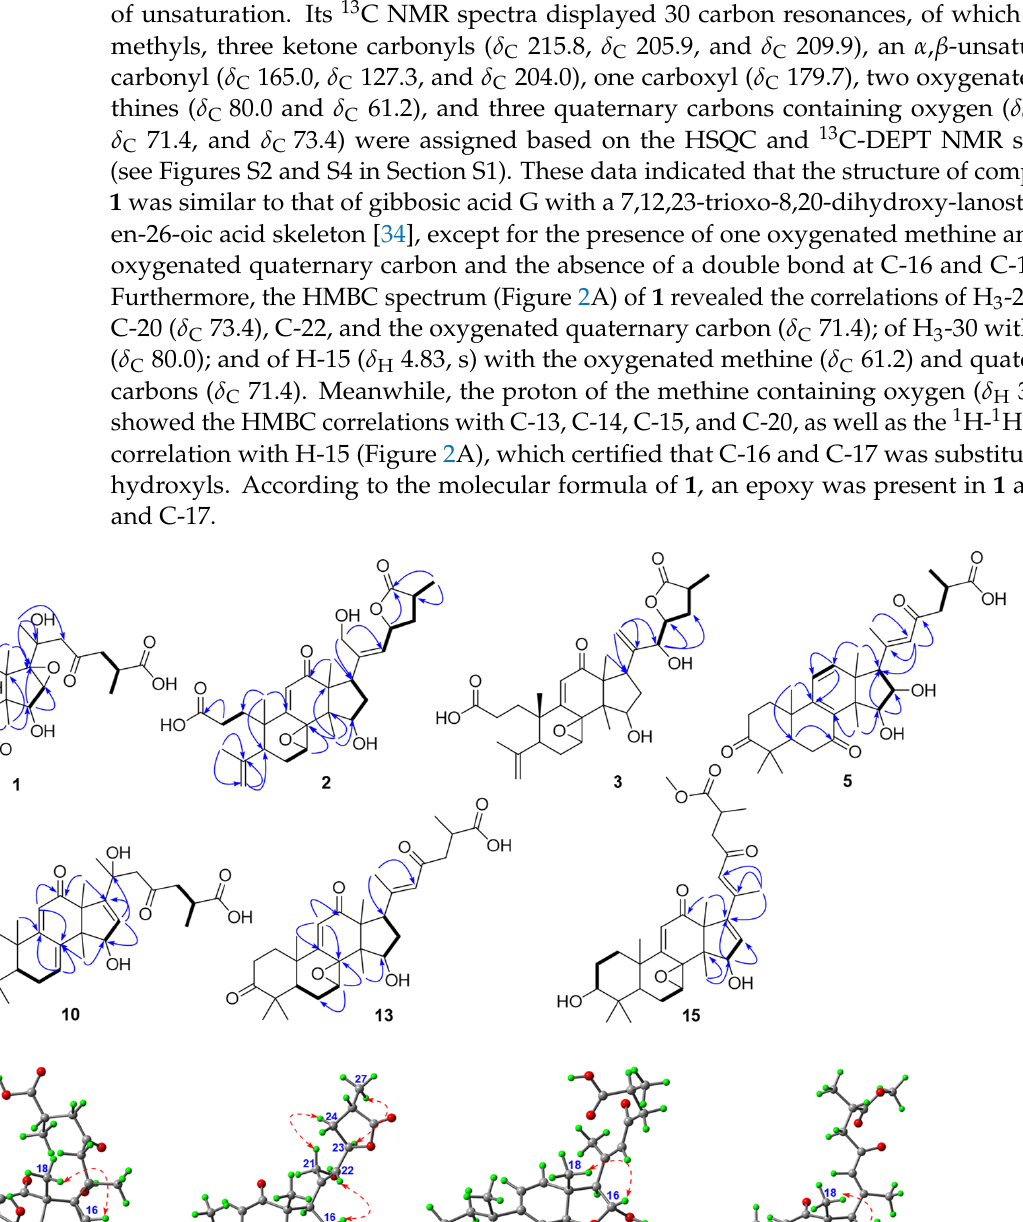
Figure 3. ( A ) X-ray crystallographic structure of 1 ; ( B ) values of δ S – δ R of the MTPA esters of 4 . Ganoapplic acid B ( 2 ) was isolated as a colorless solid. Its molecular formula was determined to be C 30 H 40 O 8 by the HRESIMS. The 1D NMR and HSQC data of 2 supported the presence of five methyls, an α , β -unsaturated ketone, two carboxyl or ester carbonyls, one oxygenated methylene ( δ H 4.37, s; δ C 61.8), three oxygenated methines ( δ H 3.95, d, J = 6.5 Hz, δ C 77.4; δ H 4.93, s, δ C 64.7; δ H 5.59, dd, J = 8.6 and 6.6 Hz, δ C 76.8), one quaternary carbon containing oxygen ( δ C 67.4), a terminal double bond ( δ C 146.5; δ C 115.9), and a dou- ble bond ( δ C 144.1; δ H 5.78, d, J = 8.6 Hz, δ C 130.8), which indicated that compound 2 was an A- seco -lanostane triterpenoid and had the similar structure to that of gibbosicolid F. [35] However, five methyls and an oxygenated methylene were observed in 2 , rather than the six methyls found in gibbosicolid F. The detailed analysis of the 2D NMR spectra (see